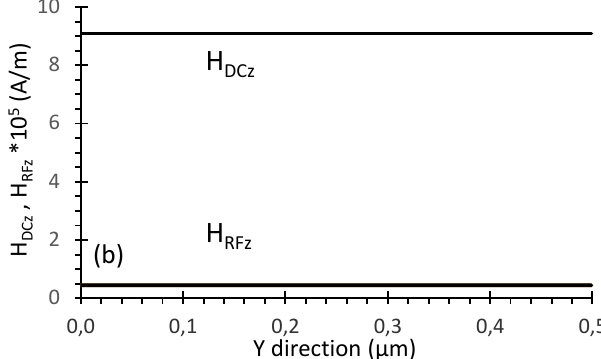
Figure 7: Spatial evolutions of the magnitude of the y direction RF field components at the fundamental frequency at respectively at x=130 µm.